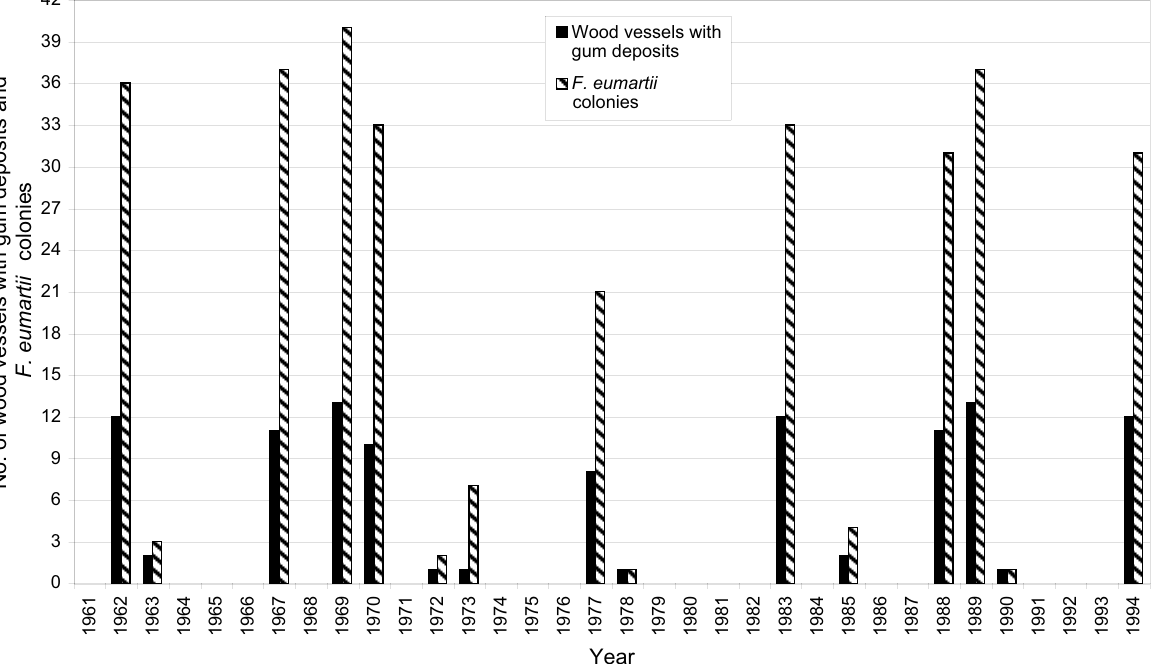
Fig. 4. Number of wood vessels filled with gum deposits from which Fusarium eumartii was isolated, and number of F. eumartii colonies obtained from gum